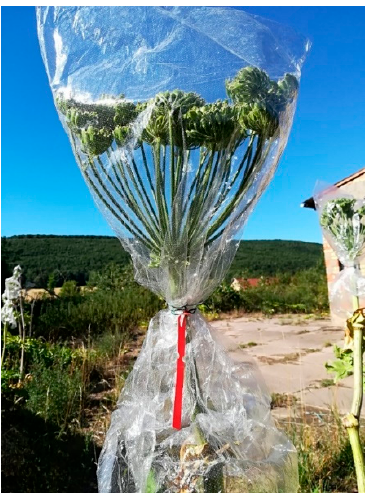
Figure A1. Main Heracleum mantegazzianum umbel wrapped with polyethylene bag.